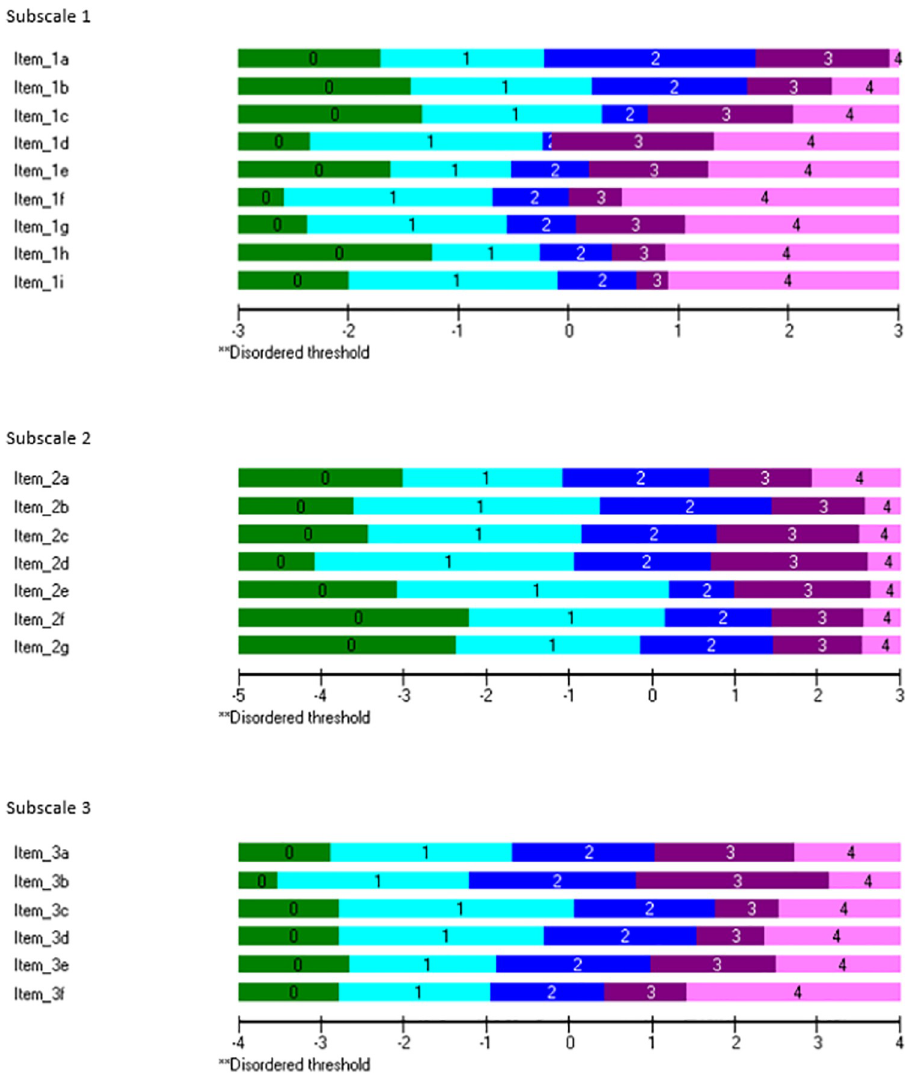
Fig 1. Ordered thresholds indicate that the item’s response categories operate